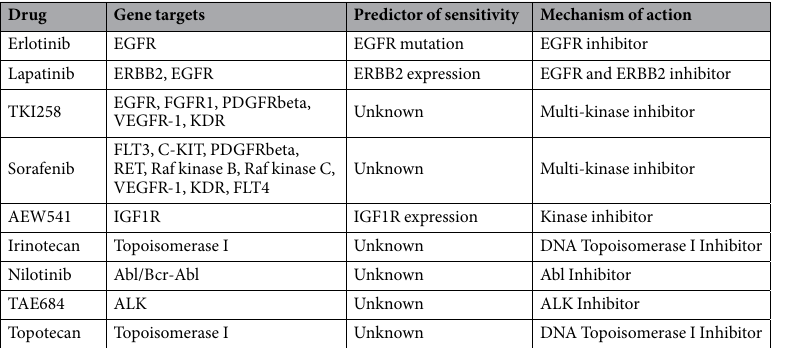
Table 2. Significant drugs in pan-cancer analysis and their gene targets (the targets, predictors of sensitivity and mechanisms of action were included from the CCLE study 31